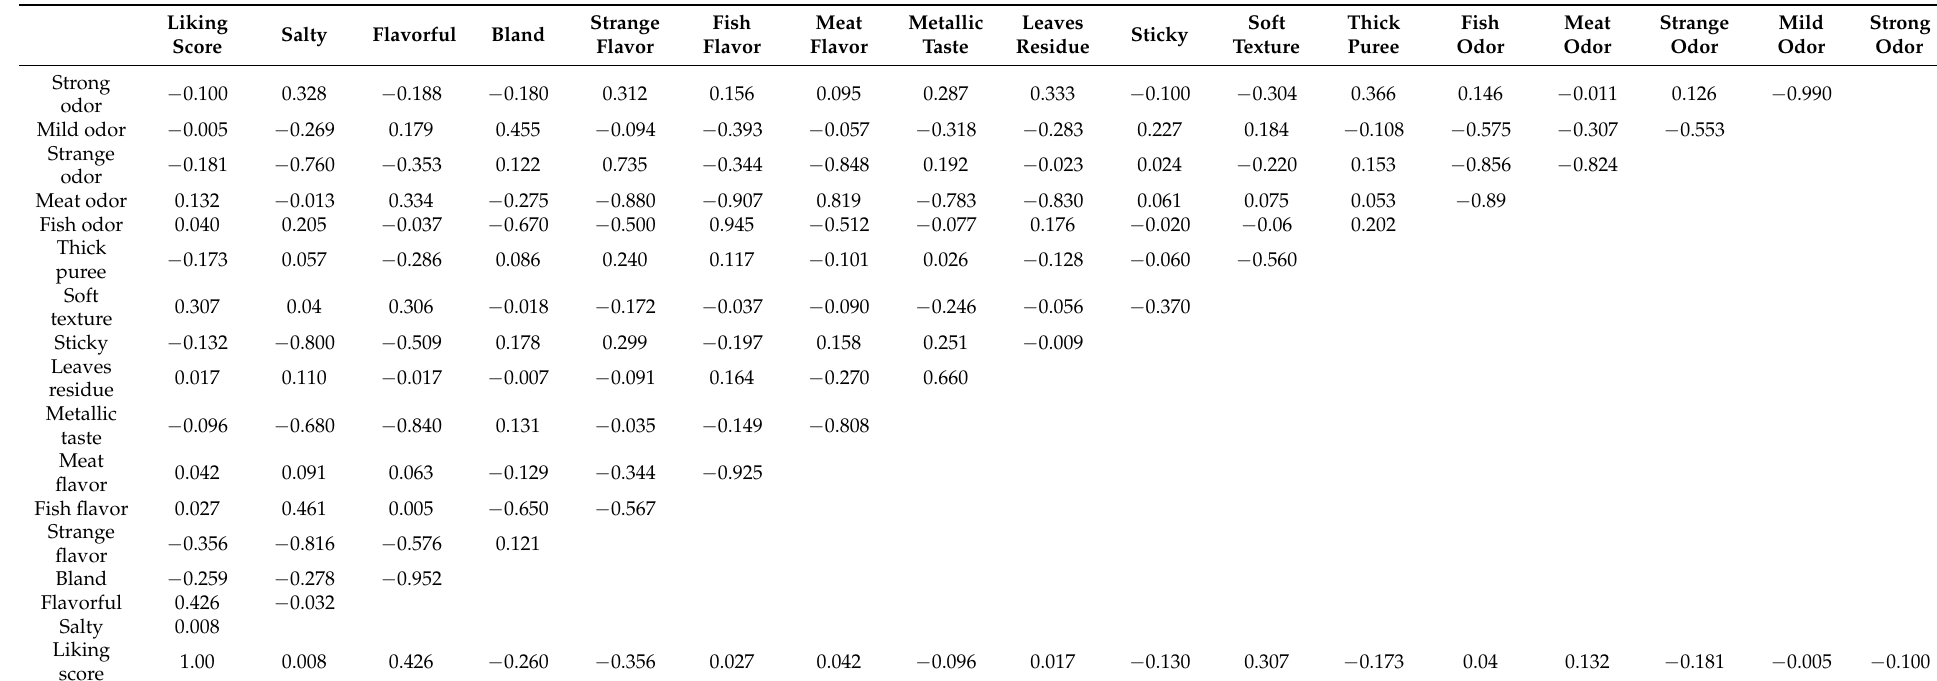
Table A2. Correlation coefficients between the attributes used to describe the texture of adapted dishes for CP